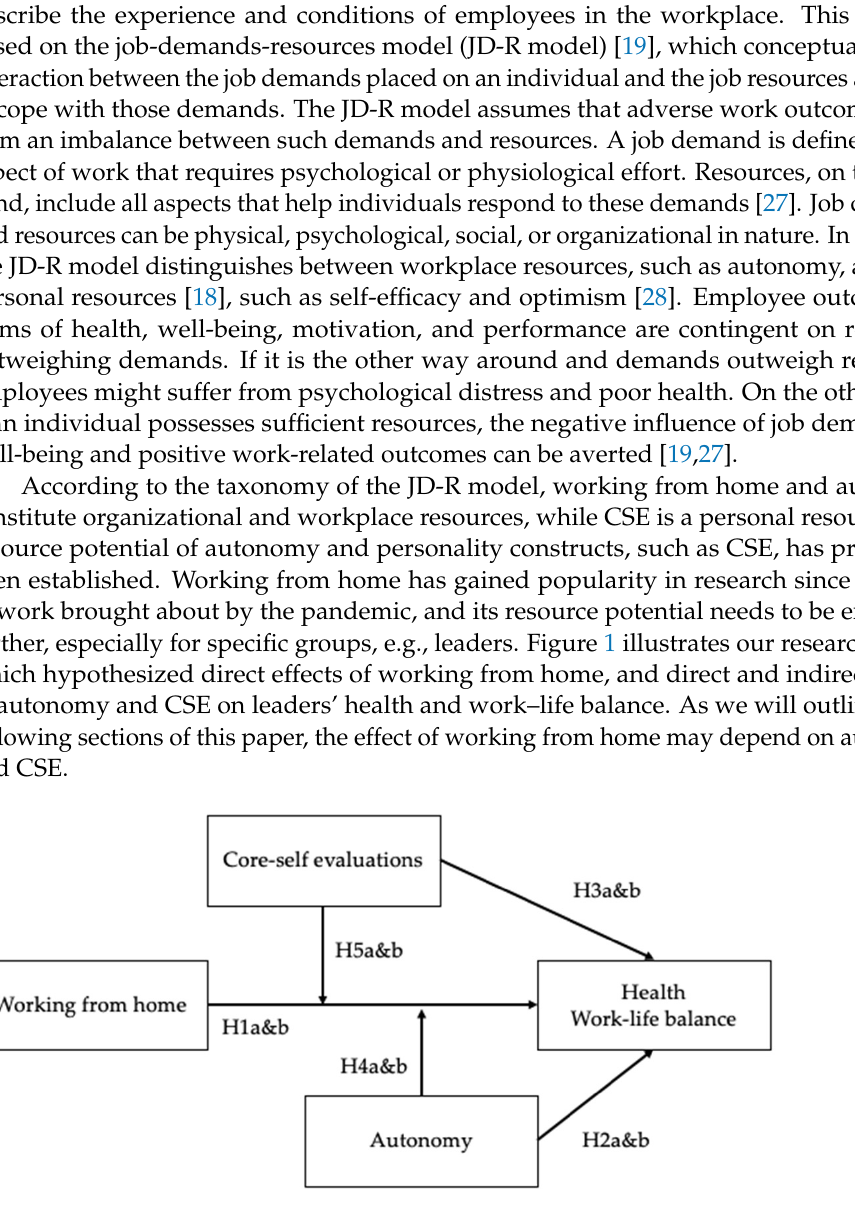
Figure 1. Conceptual model of the moderating effects of autonomy and CSE on the relationship between working from home and outcomes.